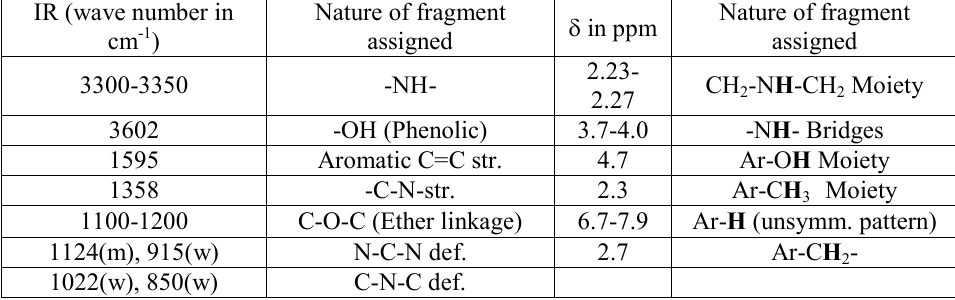
Table 3: IR and NMR spectra of m-CHF-I resin 26-32